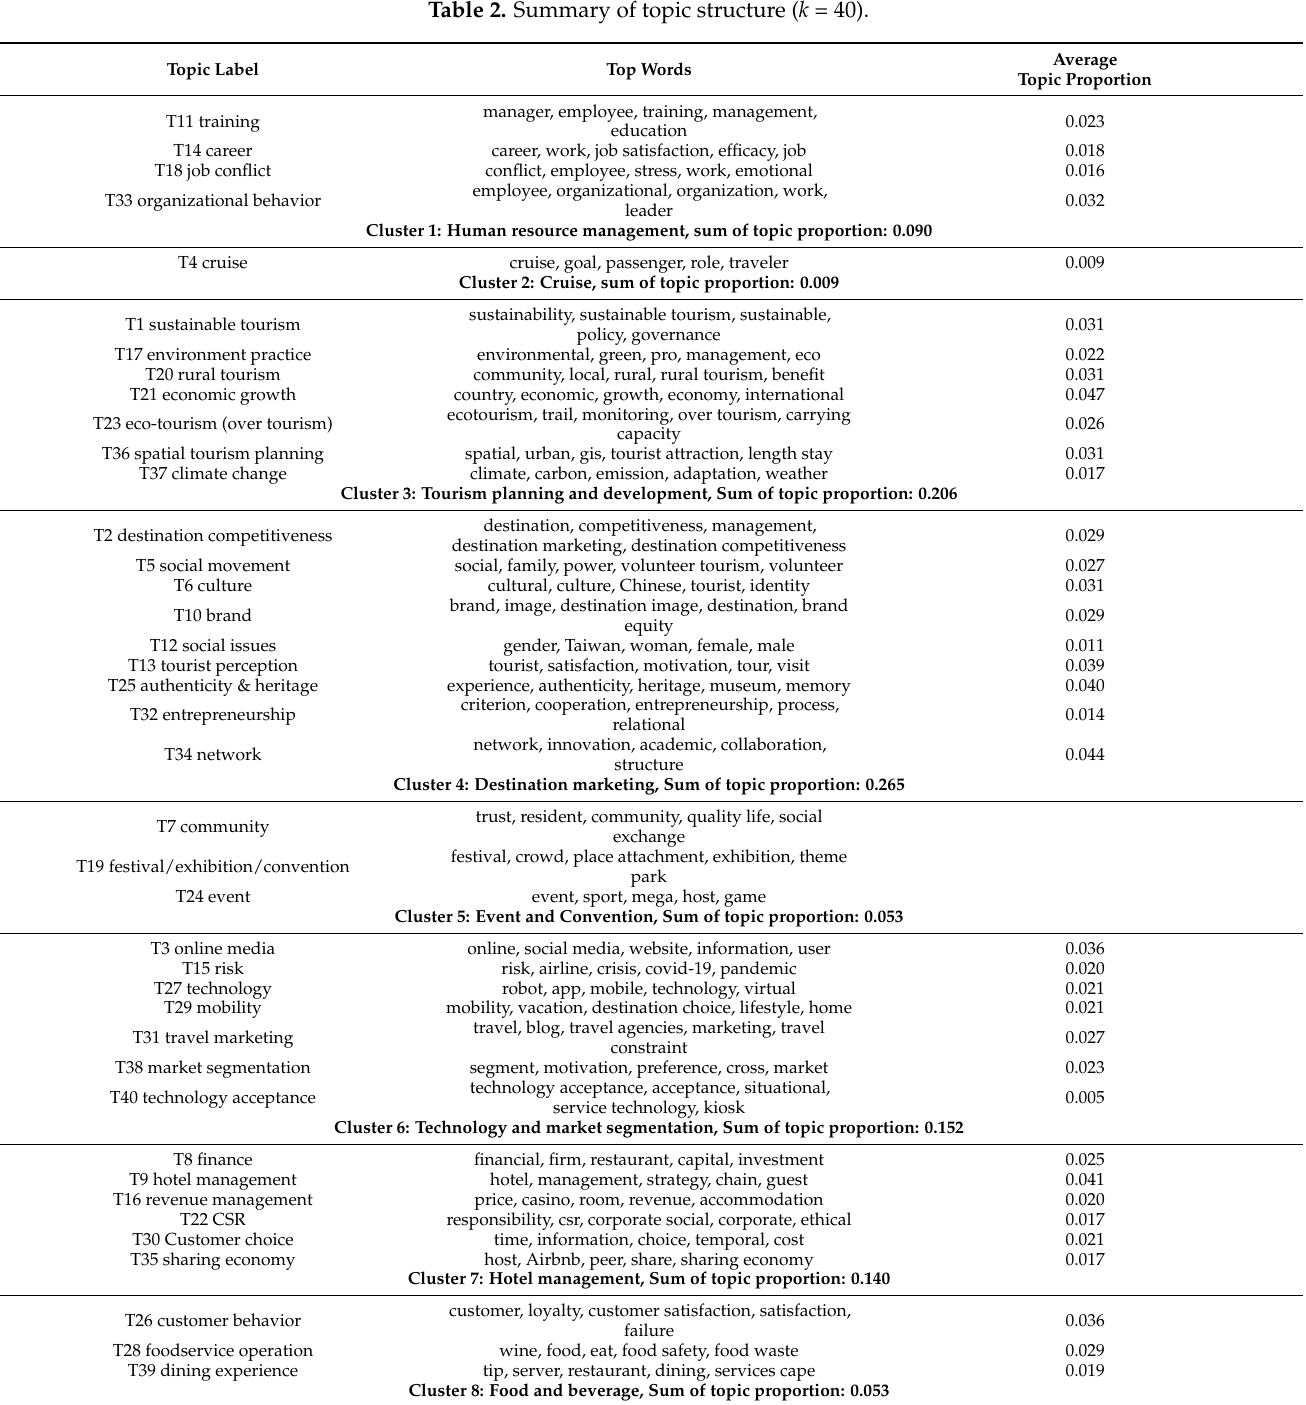
Table 2. Summary of topic structure ( k =